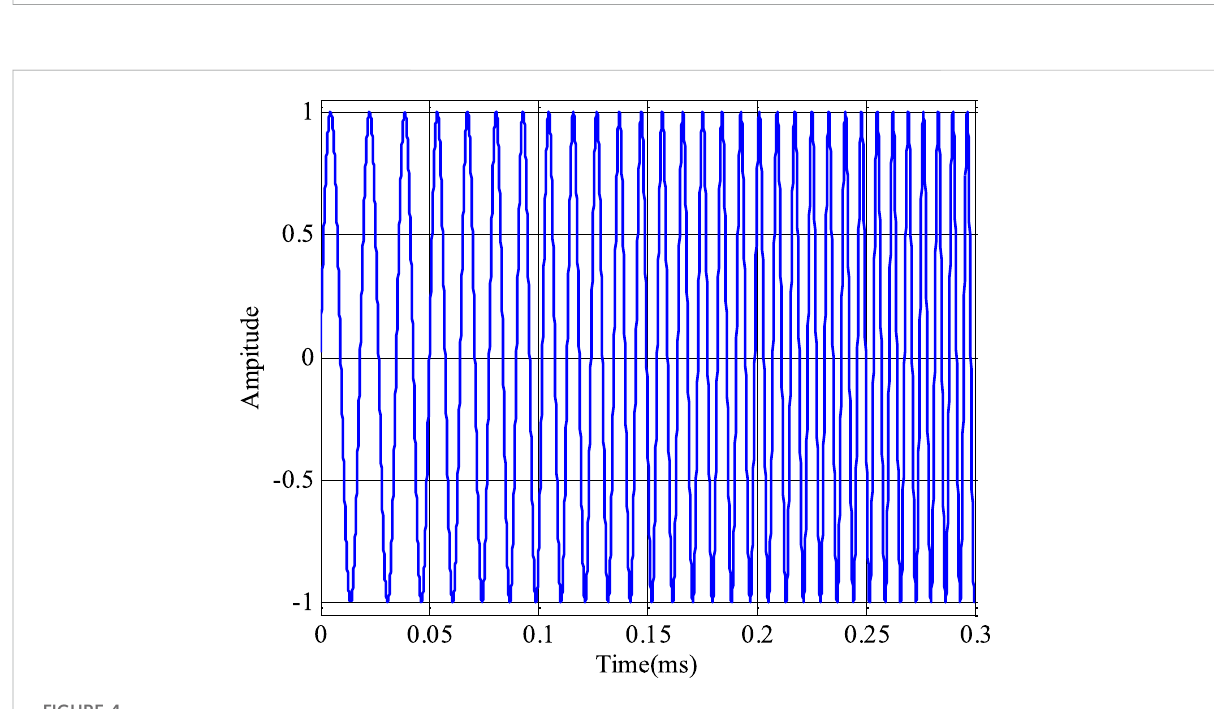
FIGURE 4 The time-domain waveform of sweeping-frequency